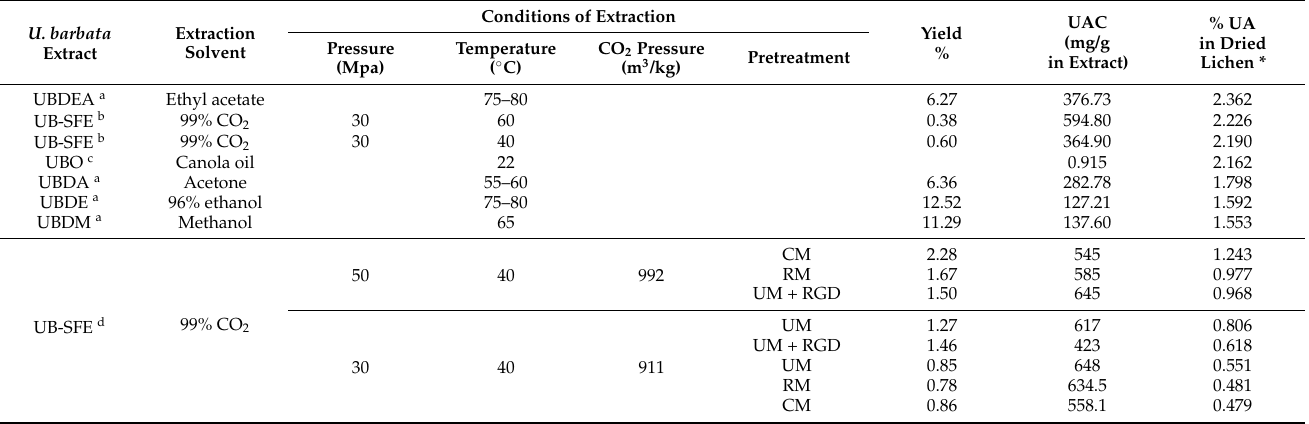
Table 8. Various U. barbata extracts with different extraction conditions correlated with the yield and usnic acid content expressed as mg/g extract, and % UA in dried